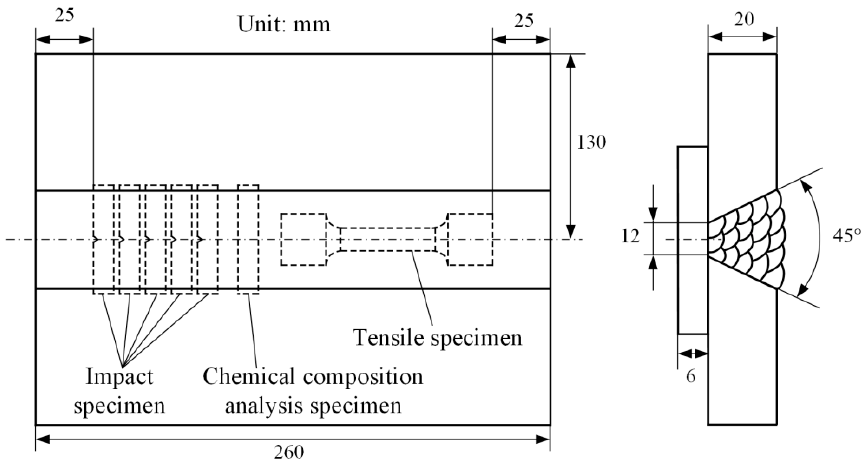
Figure 2. Schematic diagram of welded joints and selection of test specimens.